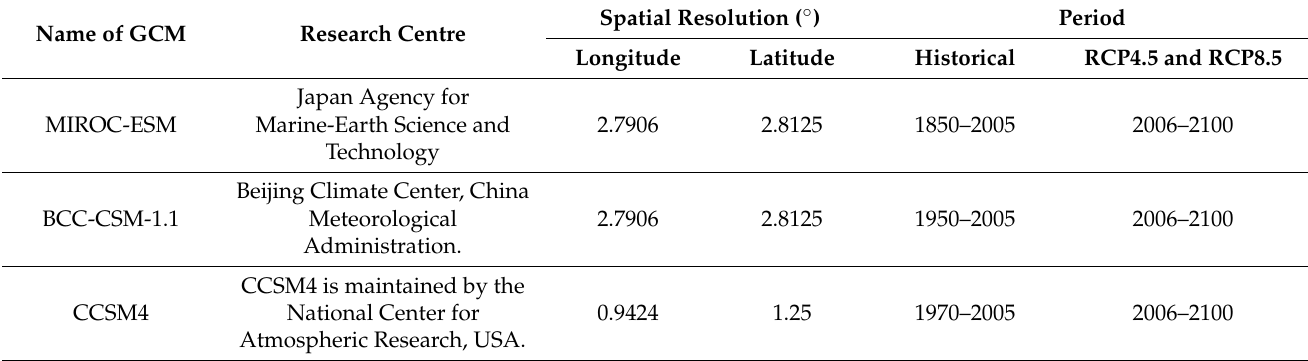
Table 2. Details of the climate models used to project climate change scenarios.